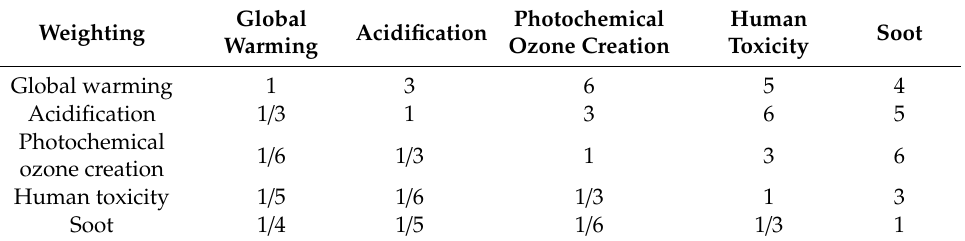
Table 5. Judgment matrix A.